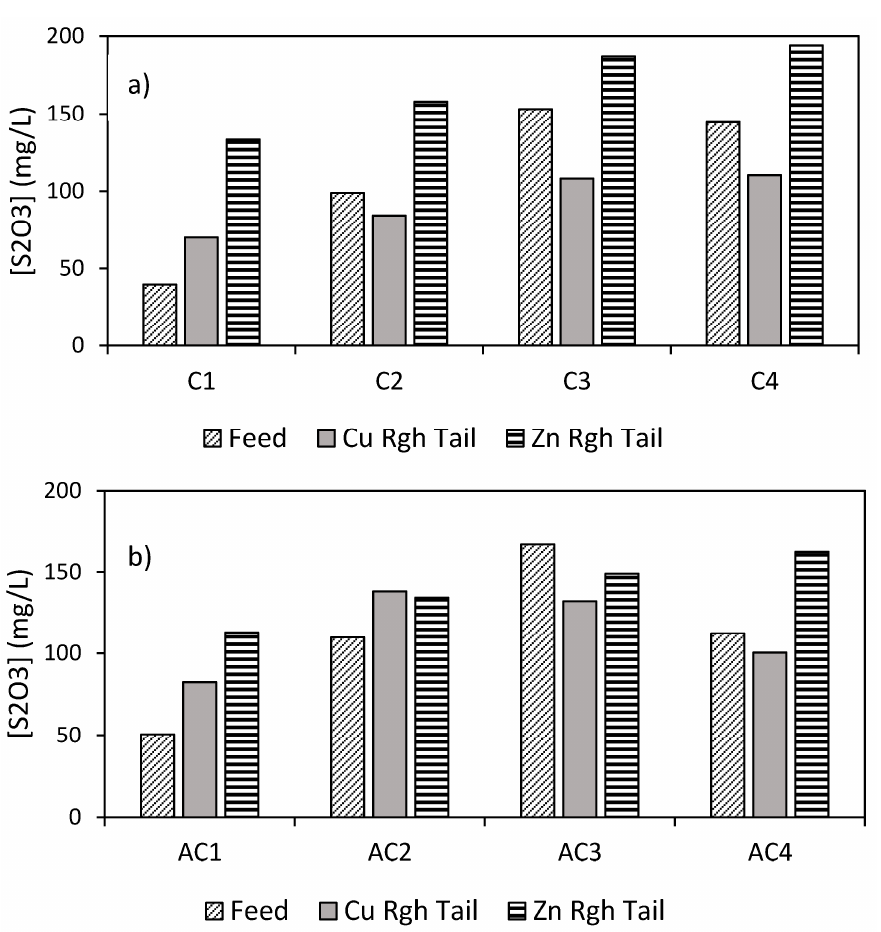
Figure 7. Dissolved ion concentration of thiosulfate ions at different stages of flotation tests during water recirculation without ( a ) and with ( b ) treatment.